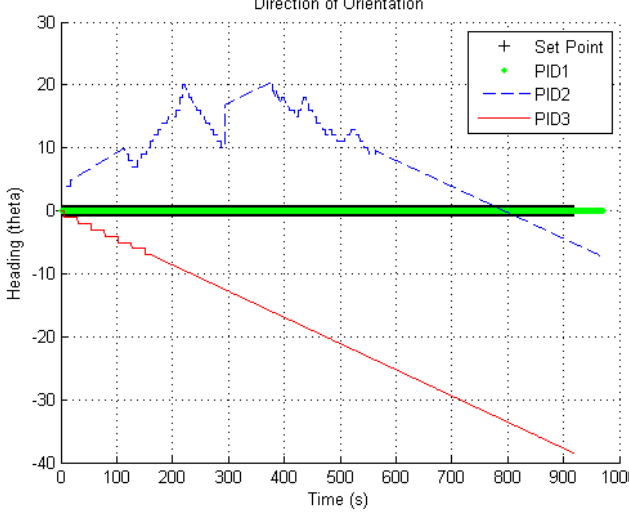
Figure 19. Robot Movement Orientation of Three PID